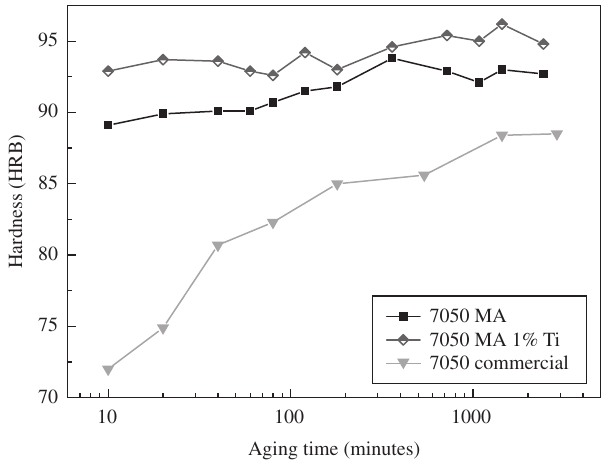
Figure 2. Ageing curves at 120 °C of 7050 commercial, 7050 MA and 7050 MA1%Ti alloys. 7050 commercial was solution treated at 478 °C and 7050 MA and 7050 MA1%Ti at 455